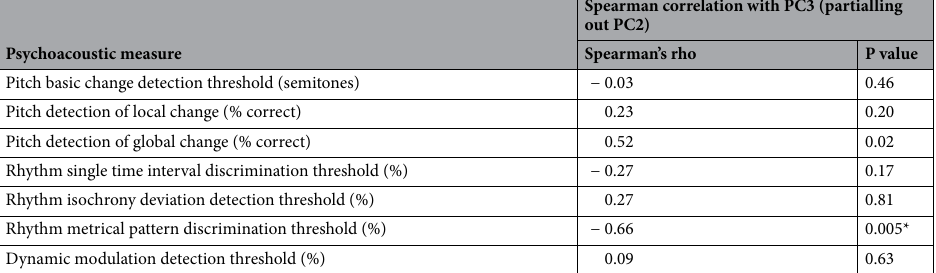
Table 4. Correlations between psychoacoustic measures and Principal Component 3 fluency, controlling for Principal Component 2. ‘P value’ corresponds to uncorrected one-sided p-values from Spearman correlations comparing psychoacoustic scores with PC3 fluency scores, partialling out PC2 scores, in the PSA subgroup. * indicates the p-value is significant at the Bonferroni corrected significance threshold of p < 0.007 (corrected for 7 comparisons). ‘PC’ = Principal